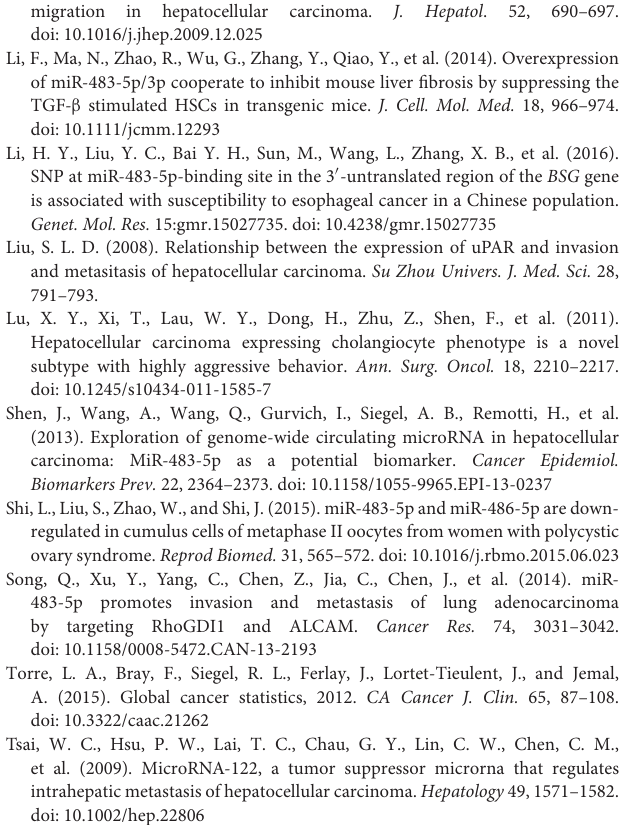
Table S1 | Primer sequence of candidate gene. Table S2 | siRNA sequences of ALCAM and NC. Table S3 | Univariate analysis of clinicopathological parameters associated with overall survival and disease-free